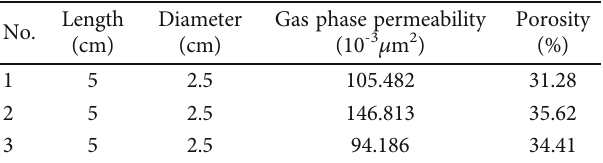
Figure 1: Experimental fl ow chart of gas-liquid two-phase relative permeability measured by steady-state method. 1: wide-mouth bottle; 2: advection pump; 3, 9: intermediate container; 4: core gripper; 5: con fi ning pressure pump; 6: gas-liquid separator; 7: wet gas fl owmeter; 8: soap fi lm fl owmeter; 10: nitrogen cylinder. Table 1: The basic data of coal